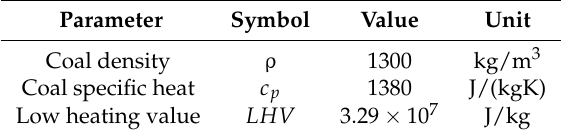
Table 8. Other parameters for the char burnout intrinsic